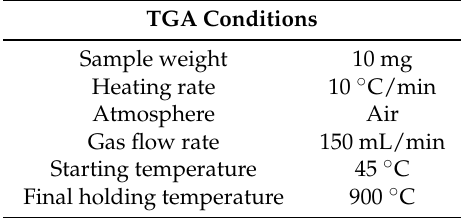
Table 2. Experimental conditions for the thermogravimetric analyzer (TGA).